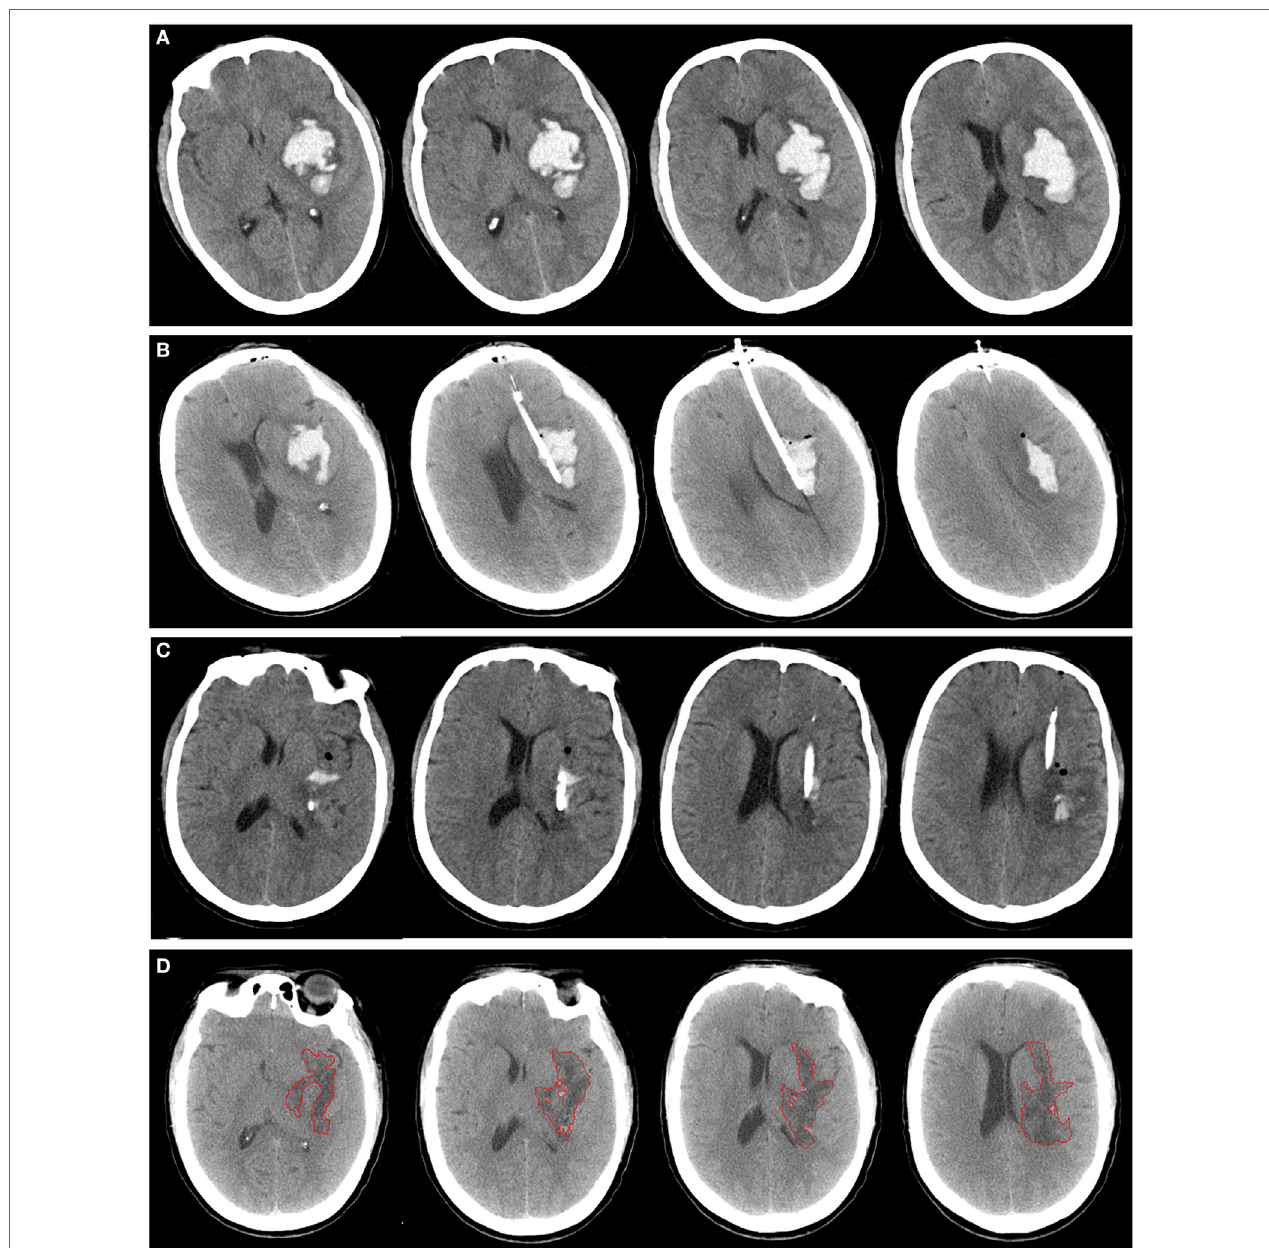
FigUre 2 | A patient with spontaneous intracerebral hemorrhage in basal ganglia received tissue-type plasminogen activator (tPA) at 24 h postoperatively. Computed tomography scan before operation (a) , at postoperative day 1 (B) , after application of tPA (c) , and postictus day 7 (D) . The perihematomal edema was semiautomatically threshold-based segmentated and outlined with red line (D)